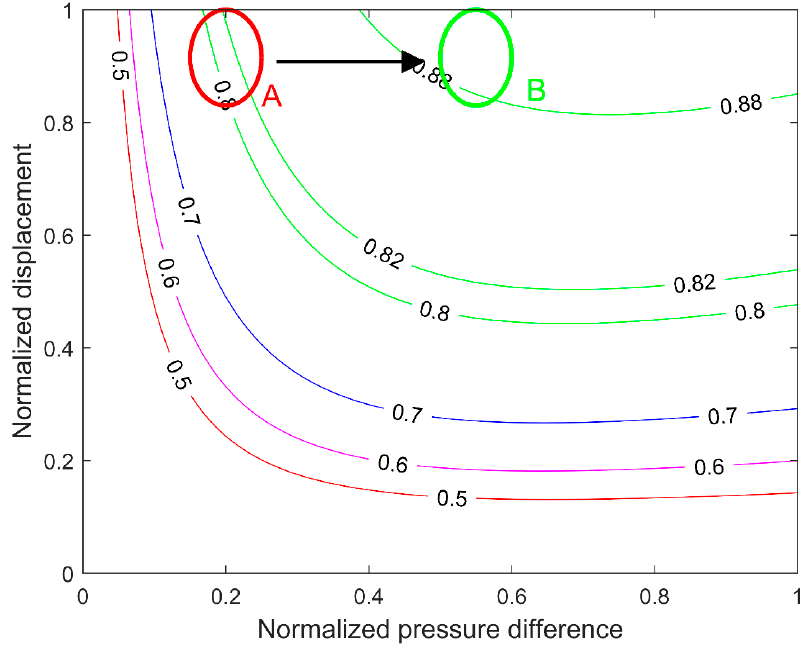
Figure 12. E ffi ciency contours as a function of the normalized pressure di ff erence and displacement in Figure 12. Efficiency contours as a function of the normalized pressure difference and displacement motoring in motoring mode.